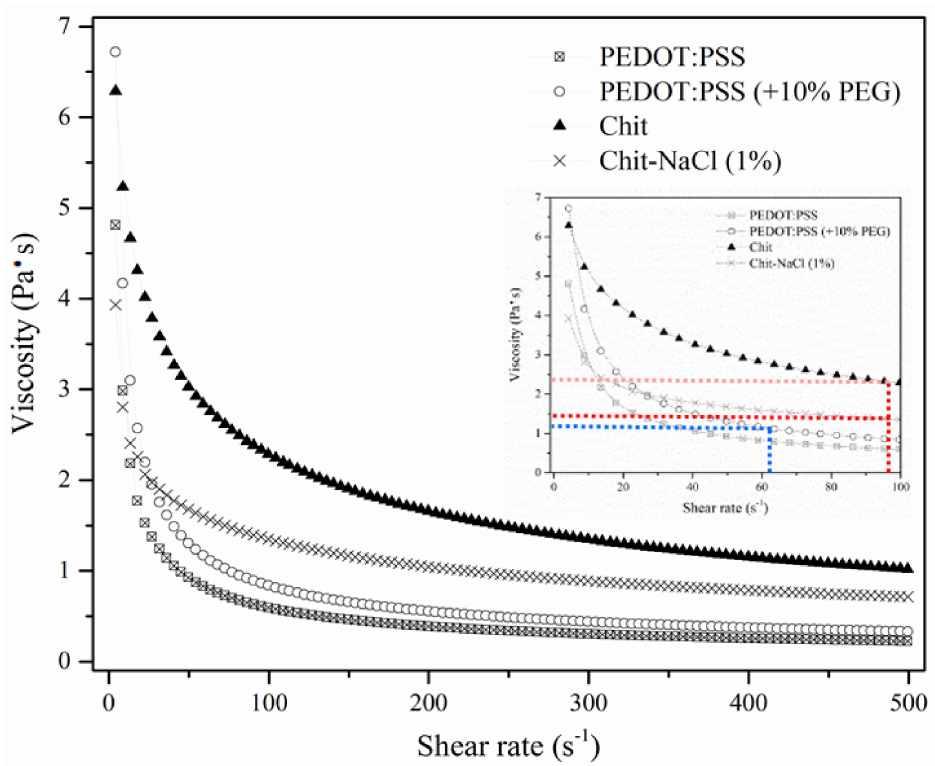
Figure 3. Viscosities of spinning solutions of PEDOT:PSS with and without addition of polyethylene glycol (PEG), chitosan and Chit-NaCl (1%) solutions, inset; viscosity changes vs. shear rate at different rates between 0.1 and 100 s − 1